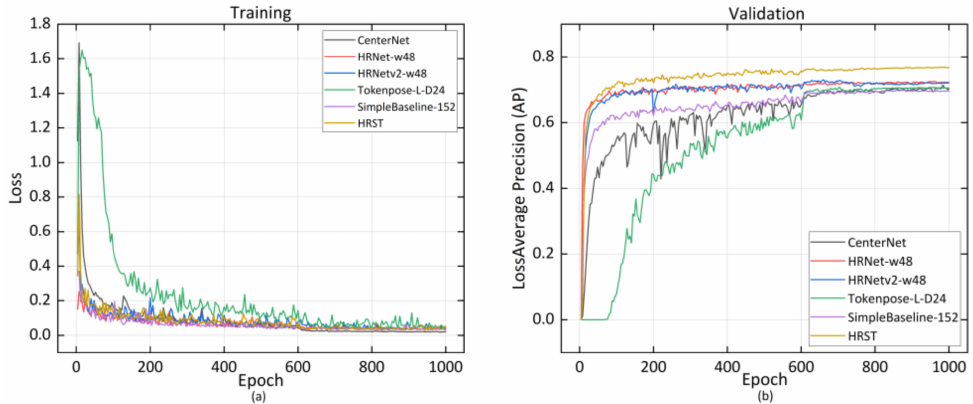
Figure 6. The training loss curve ( a ) and AP curve ( b ) of joint points detection